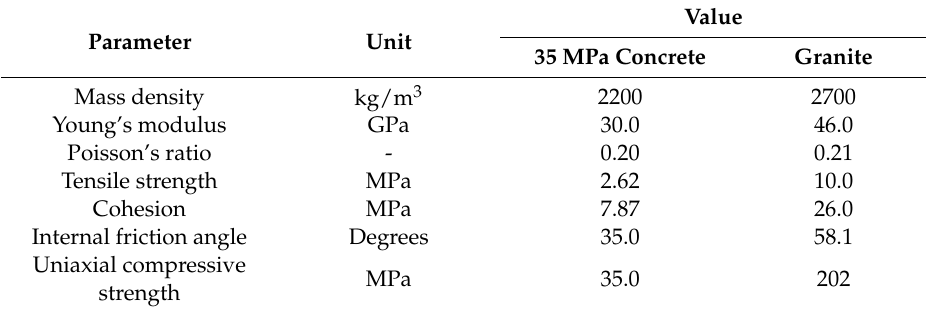
Table 1. Experimentally obtained physical and mechanical properties of 35 MPa concrete and granite. Parameter Unit